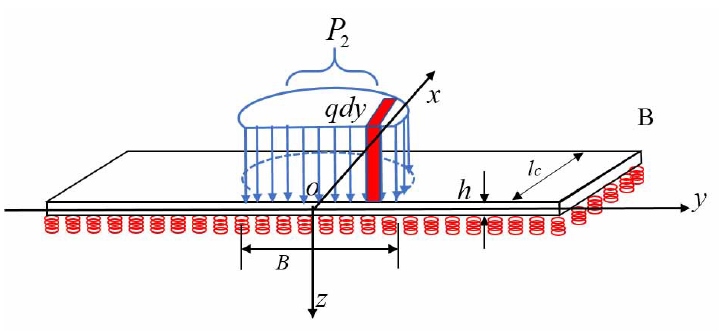
Figure 5. Infinite elastic plate resting on an elastic